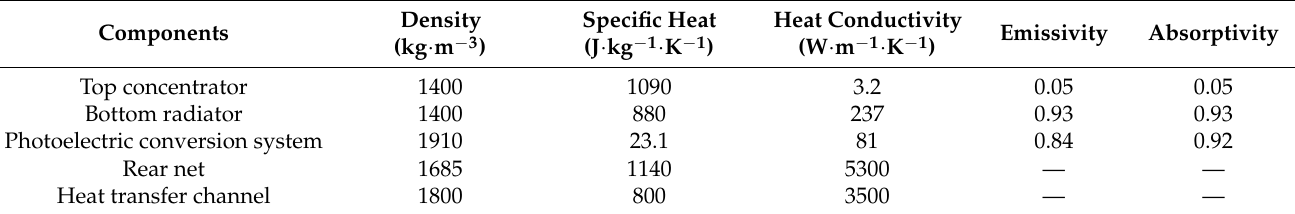
( d ) Figure 17. Temperature distribution of two-layer ring truss-based SSPS in orbit: ( a ) the whole sys- tem; ( b ) the disc-shaped PV cell array; ( c ) photoelectric conversion system; ( d ) bottom layer space radiator.